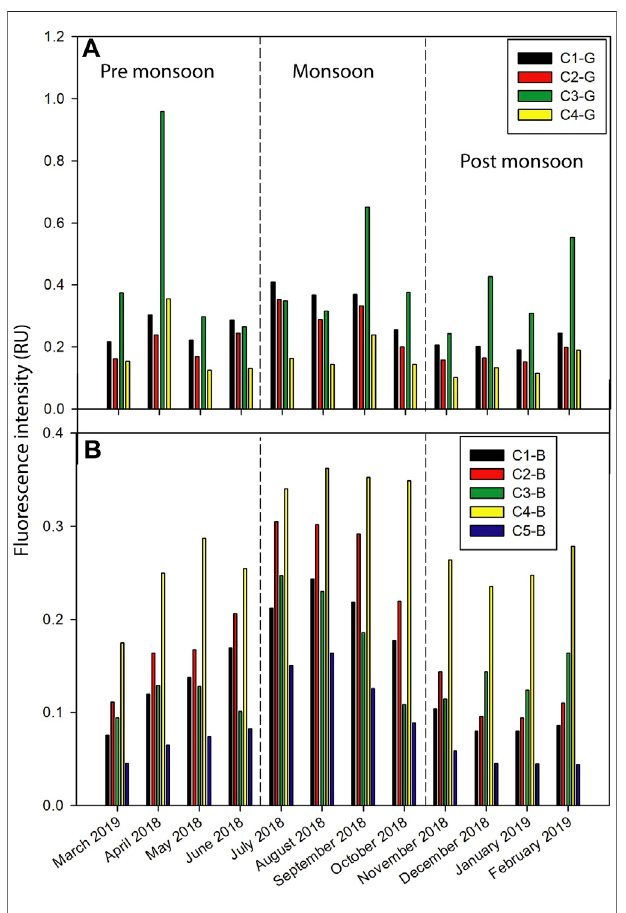
FIGURE3| Fluorescence intensityofcomponentsinthedownstreamof (A) the Ganges and (B) Brahmaputra rivers.